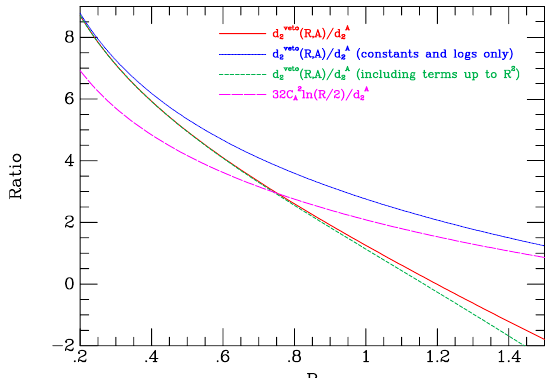
( R, A ) scaled by the constant d A . The full result, eq. (2.17) is 2 2 = 0 , is 32 C 2 ln( R/ 2) and is shown in f A = 5 f